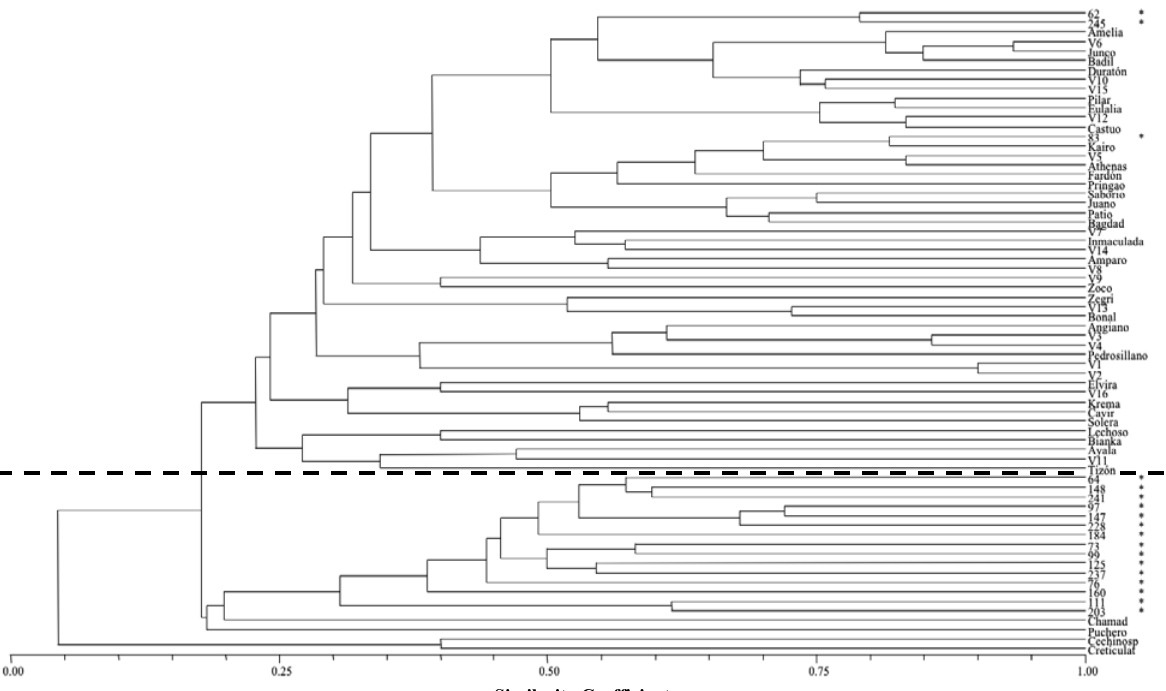
Figure 2. UPGMA dendrogram obtained from cluster analyses of 18 Italian chickpea landraces (marked with asterisks) and 48 Spanish cul- tivars, based on Dice coefficients of similarity, using 12 microsatellite markers selected for their Polymorphism Information Content (PIC) values. The dotted line separates two Subgroups, which mainly include Italian (Sub-group 1) and Spanish (Sub-group 2) chickpea lines. Cicer reticulatum and Cicer echicnospermum were included as outgroup